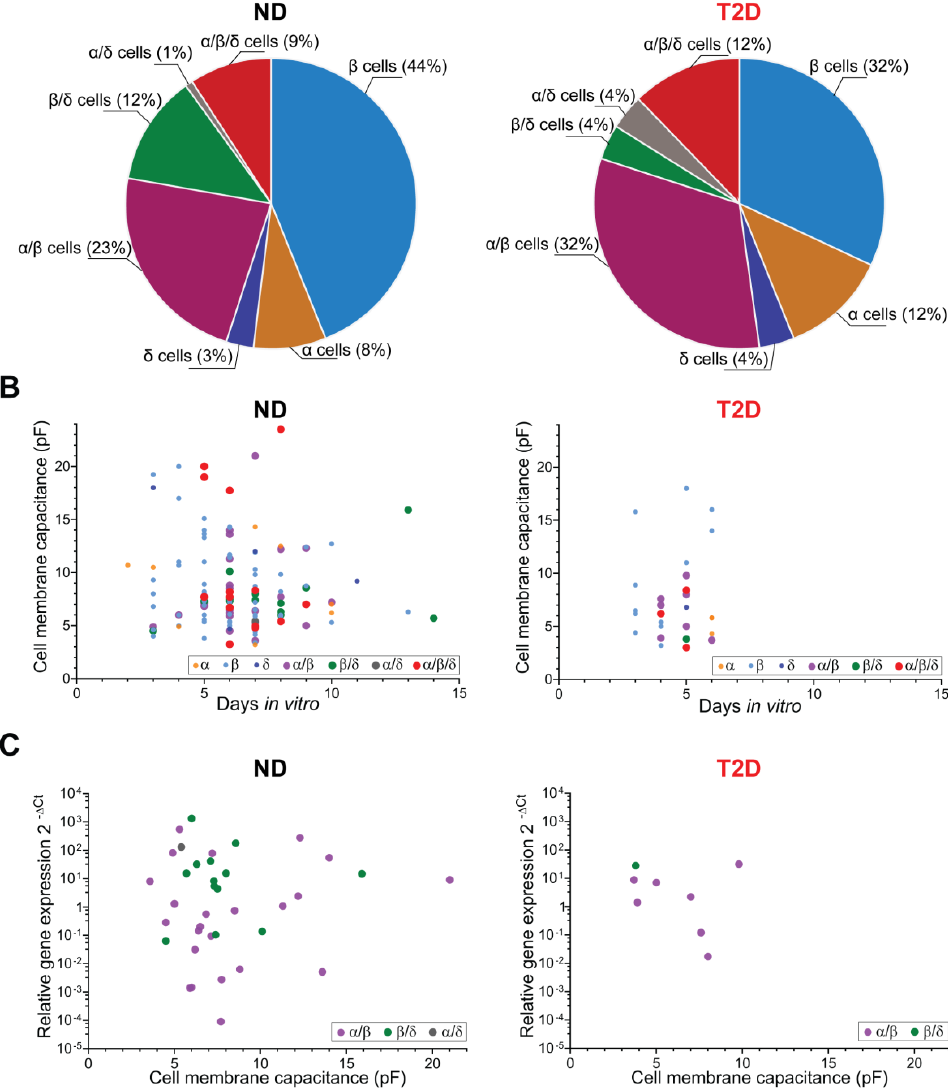
Figure 1. Percentage distribution of single and multiple hormone transcript-expressing cells ( A ) and relations between duration of islet culturing ( B ) and relative gene expression ( C ) versus cell membrane capacitance in intact human pancreatic islets from non-diabetic (ND) and type 2 diabetic (T2D) donors. Relative gene expression in ( C ) is read as the GCG / INS expression ratio for mixed-identity α/β cells (magenta circles, ND: n = 23, T2D: n = 7), INS / SST expression ratio for mixed-identity β/δ cells (green circles, ND: n = 13, T2D: n = 1) and GCG / SST expression ratio for mixed-identity α/δ cell (gray circle, ND: n = 1). Correlations neither in (B) (Spearman correlation coefficient for ND group r = −0.057, p = 0.52, n = 130; for T2D group r = 0.010, p = 0.96, n = 27), nor in (C) (Spearman correlation coefficient for ND group r = −0.019, p = 0.910, n = 37; for T2D group r = −0.238, p = 0.582, n = 8) are revealed. Cell membrane capacitance was measured at the holding potential, V h = −70 mV. Glucose concentration in all experiments was 20 mM.